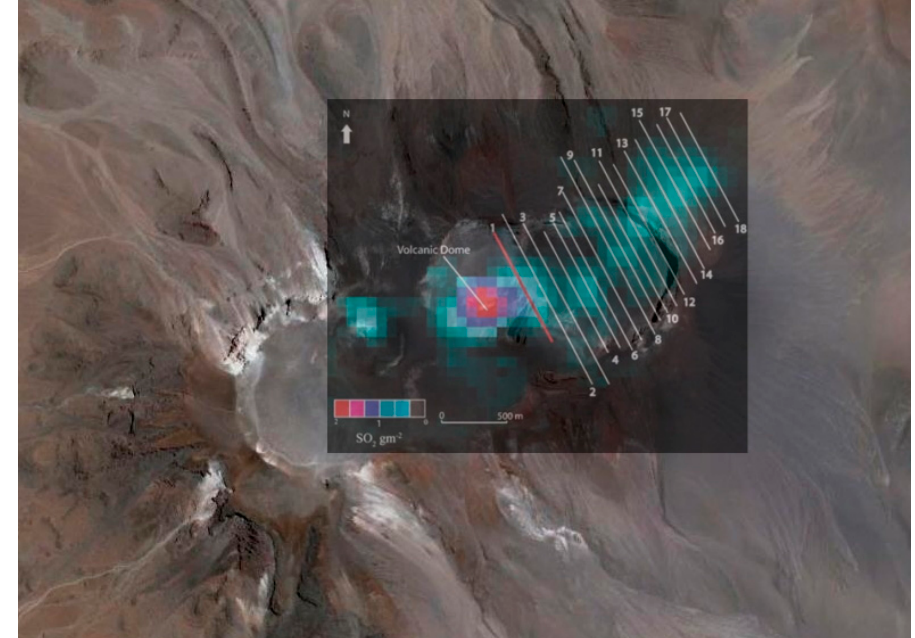
Figure 4. The map of the very low SO 2 burden retrieved using ASTER TIR data acquired at Lascar volcano, Chile (summit location: 23.37 ◦ S, 67.73 ◦ W) on 7 December 2004. Image is draped on a visible Google Earth image for context. Numbered lines indicate transects taken through the plume and reported in the original study. SO 2 results were created using the Map_SO 2 software of Realmuto [41] and each color bin corresponds to ~0.3 g / m 2 of SO 2 . Figure modified from Henney et al. [40].